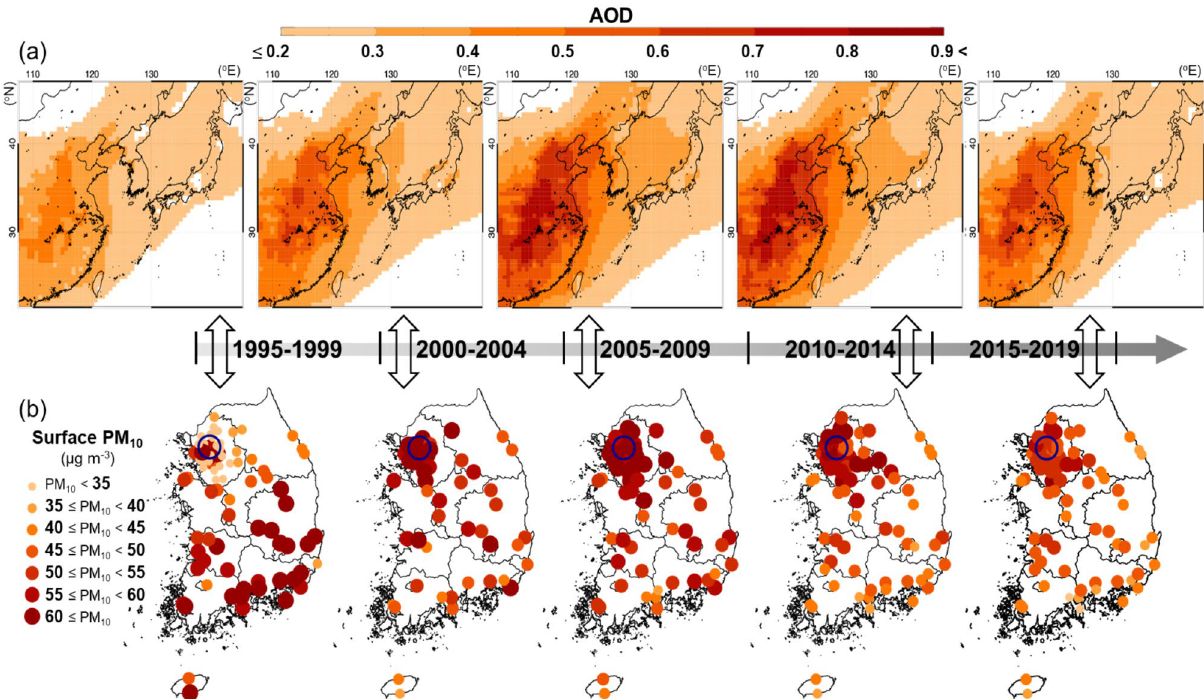
Figure 2. Time series of 5-year averaged horizontal distributions of ( a ) aerosol optical depth using MERRA-2 data in Northeast Asia and ( b ) in situ PM 10 surface measurements in South Korea. The blue circles indicate the location of